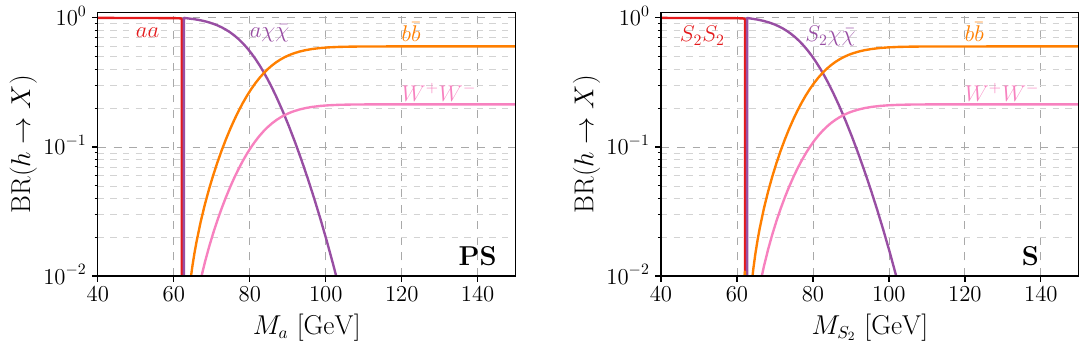
Figure 1 . Dominant branching ratios of the SM Higgs-like scalar h for tan (cid:12) = 1, m (cid:31) = 10 GeV and other parameter values as given in eq. (4.4) in the 2HDM+PS (left) and 2HDM+S (right).